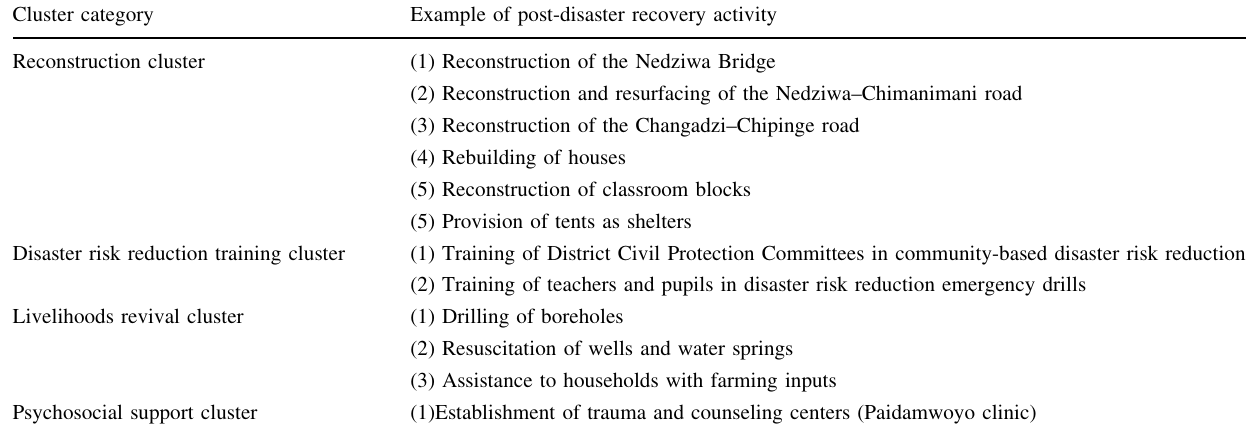
Table 3 Cyclone Idai post-disaster recovery build-back-better clusters Cluster category Example of post-disaster recovery